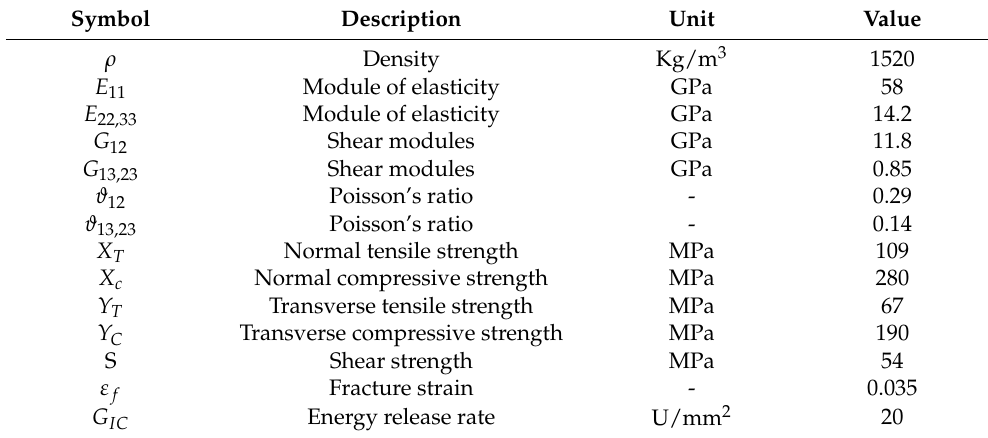
Table 2. The material properties of hybrid carbon/glass fibre/epoxy unidirectional composite.